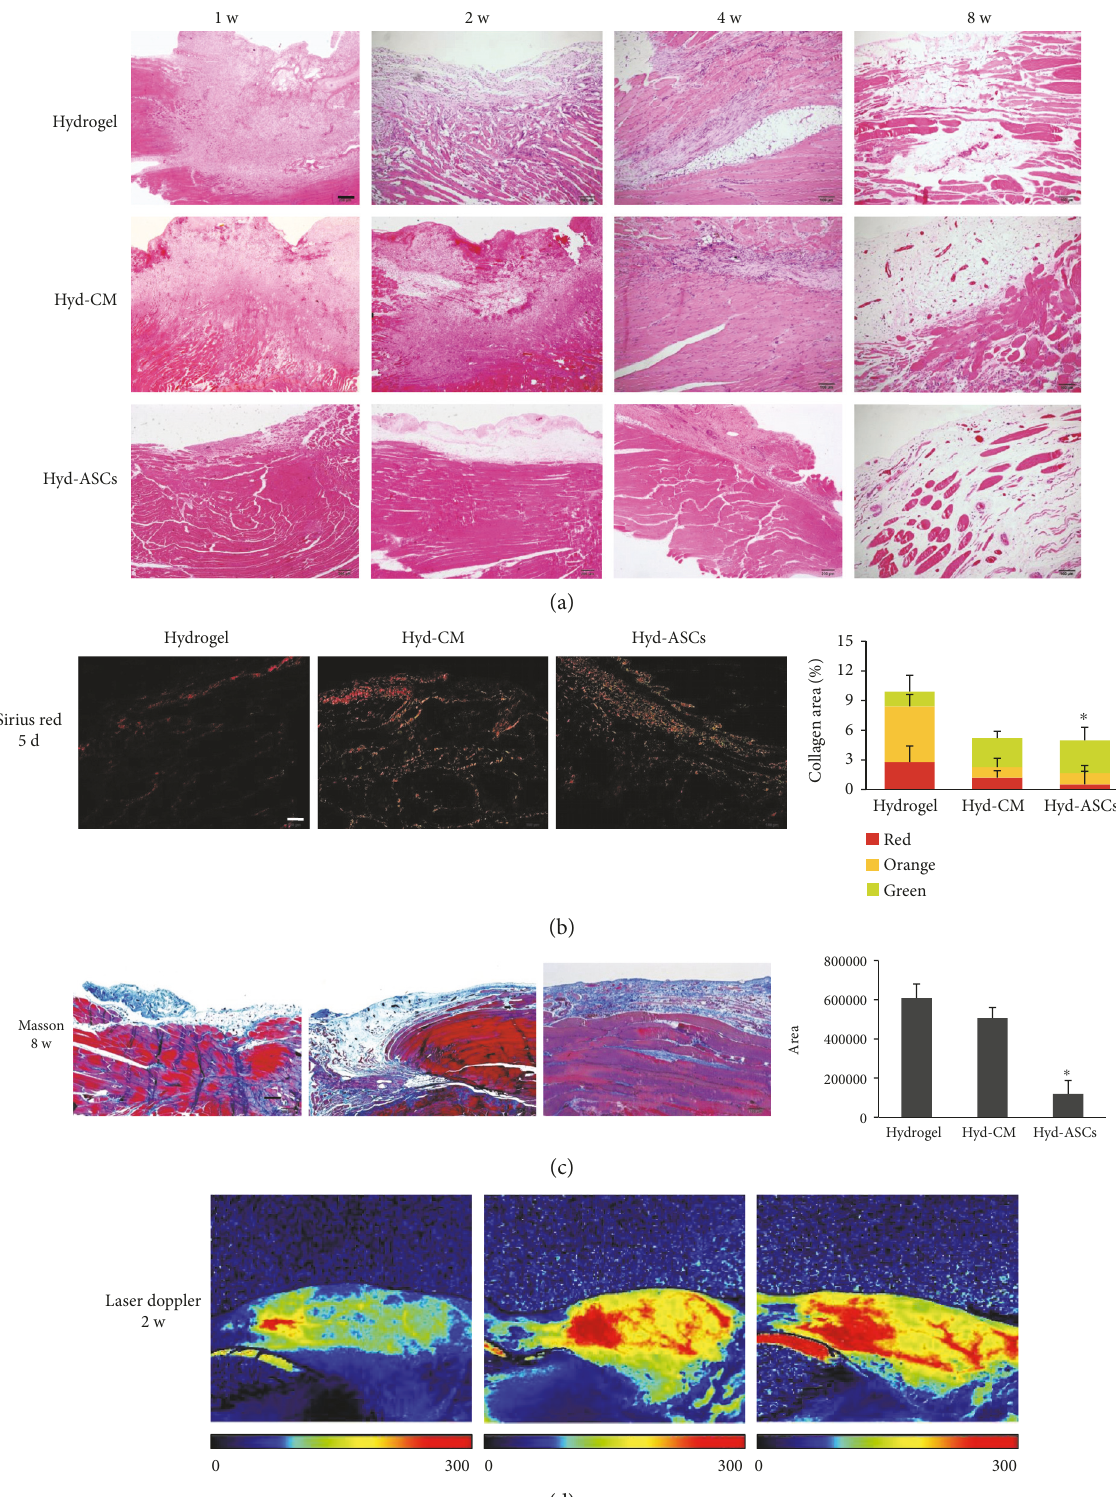
Figure 3: rASC-based hydrogel accelerating muscle regeneration. (a) H&E staining of TA muscle during repair and regeneration at 1w, 2w, 4w, and 8 w post injury. Scale bar =100 μ m. (b) Sirius Red staining at 5 d post injury and collagen analyzed. Scale bar =100 μ m. (c) Masson trichrome staining of TA muscle at 8 w post injury and collagen analyzed. Scale bar =200 μ m. (d) Laser Doppler perfusion images at 2w post injury. Images above were representatives of at least three independent experiments. Data were mean ± SEM of three independent experiments. ∗ p < 0 05 versus hydrogel